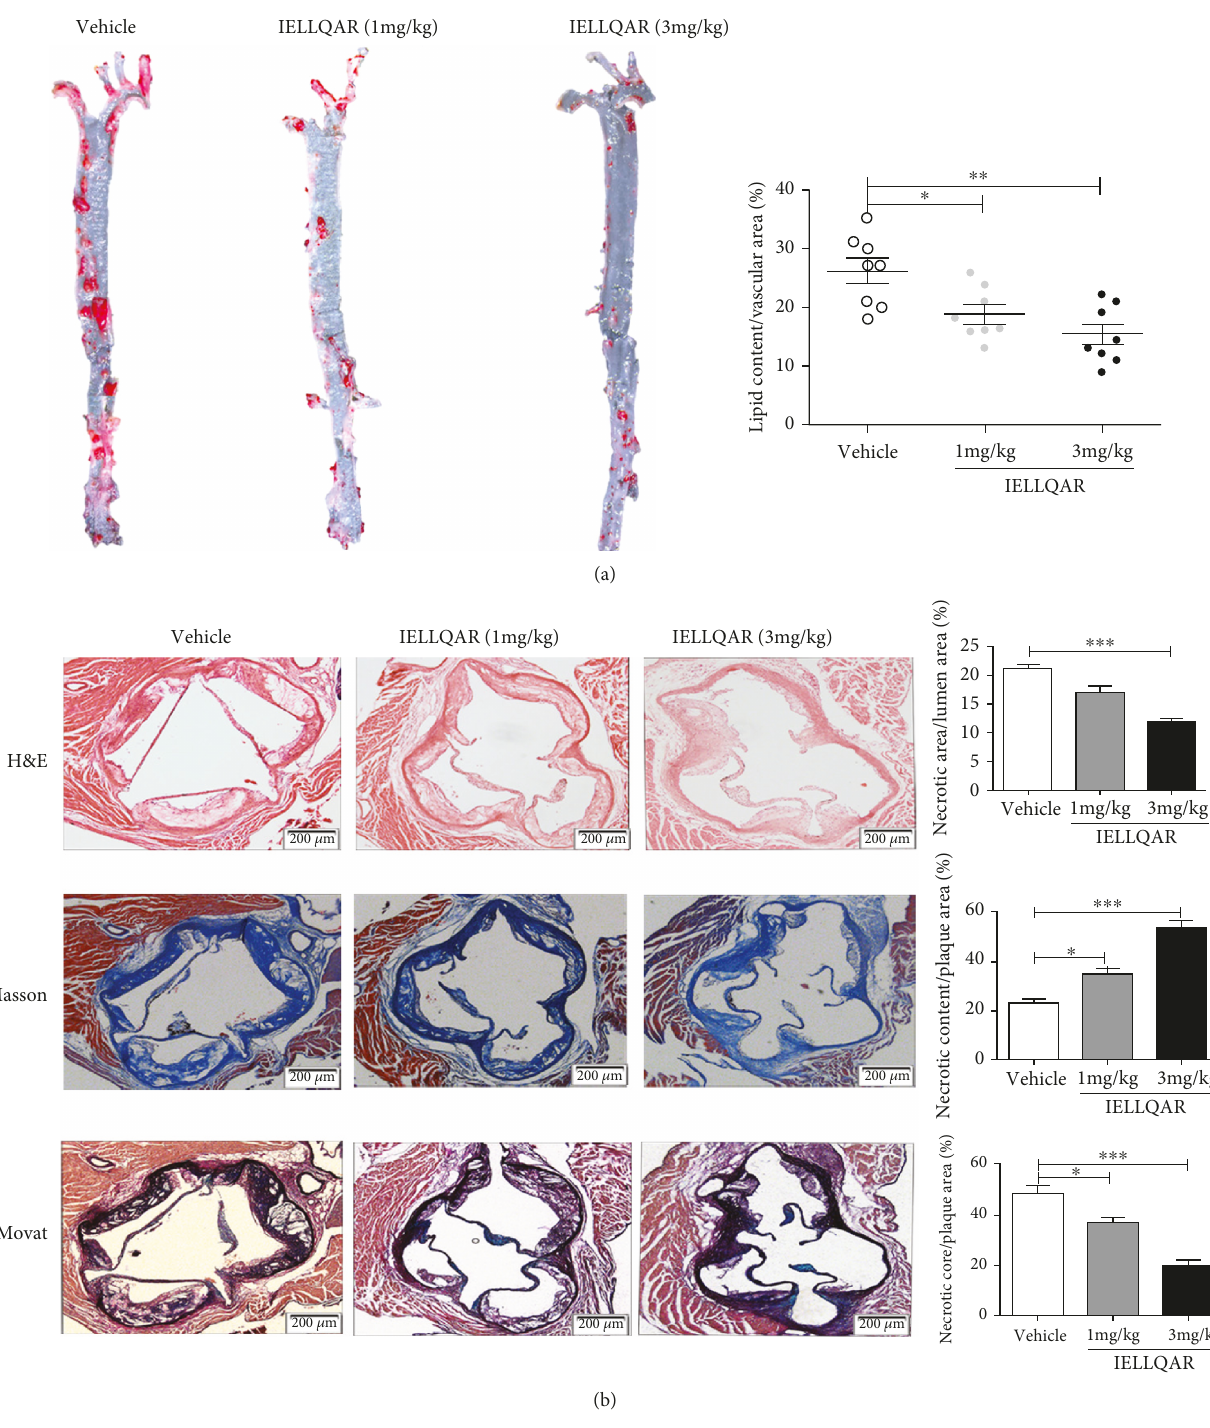
Figure 3: IELLQAR decreases atherosclerotic lesions in WTD-induced mice. Eight-week-old male ApoE -/- mice were randomized into one of three treatment groups: IELLQAR (1 or 3 mg/kg) or vehicle. All mice were fed a high-fat diet for 12 weeks. (a) Representative images of Oil red O staining of the whole aorta after en face preparation and quanti fi cation of lipid content (lipid content/vascular area) ( n ≥ 8 ). (b) Representative histological analysis results of the aortic sinus following H&E, Masson ’ s trichrome, and Movat staining and quanti fi cation of the plaque area (plaque area/lumen area), collagen content (collagen content/plaque area), and necrotic area (necrotic area/plaque area) in the aortic sinus ( n ≥ 5 ). Scale bar: 200 μ m. Data are presented as the mean ± SEM . ∗ p < 0 05 , ∗∗ p < 0 01 , and ∗∗∗ p < 0 001